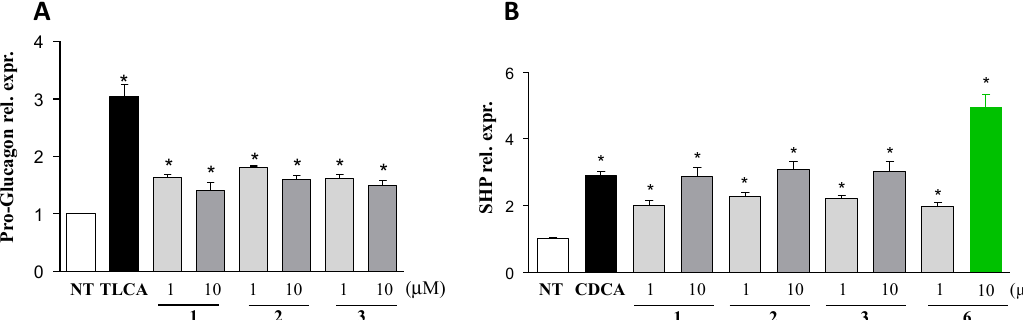
Figure 2. RT-PCR analysis of mRNA expression on ( A ) GPBAR1 target gene proglucagon and ( B ) on FXR target gene SHP in murine GLUTag cells and human HepG2 cells, respectively. In panel A cells were primed with TLCA (10 µM), or with increasing dose of compounds 1 – 3 (1 and 10 µM), or with vehicle (DMSO) alone. In panel B, cells were primed with CDCA (10 µM), or with increasing dose of compounds 1 – 3 , and 6 (1 and 10 µM), or with vehicle (DMSO) alone. Values are normalized to GAPDH. The relative mRNA expression is analyzed according to the CT method. Data were calculated from at least three experiments. Results are expressed as mean ± SEM * p < 0.05 versus not treated cells (NT), arbitrarily settled as 1.